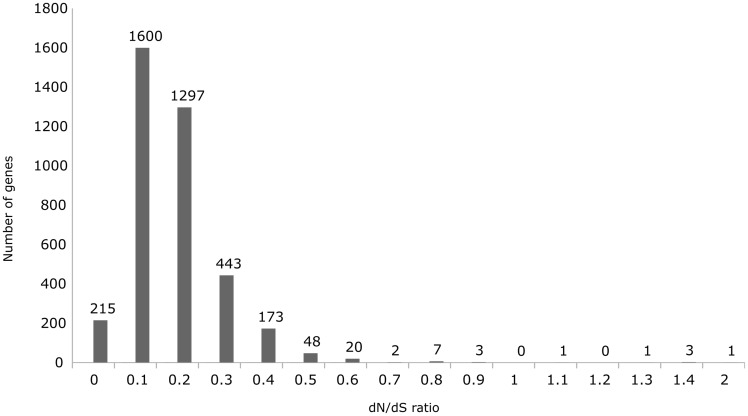
—dN/dS ratio (omega values) for the overall 3,814 core genes. The mean pairwise dN/dS ratio for the 3,814 core genes is 0.14. The ratio of almost all the core genes is between 0 and 1. There are only six genes that show the dN/dS ratio between 1 and 2.